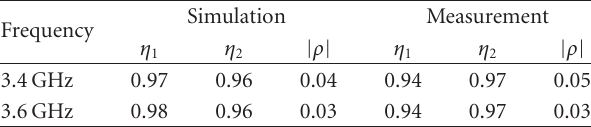
Table 1: Multiantenna